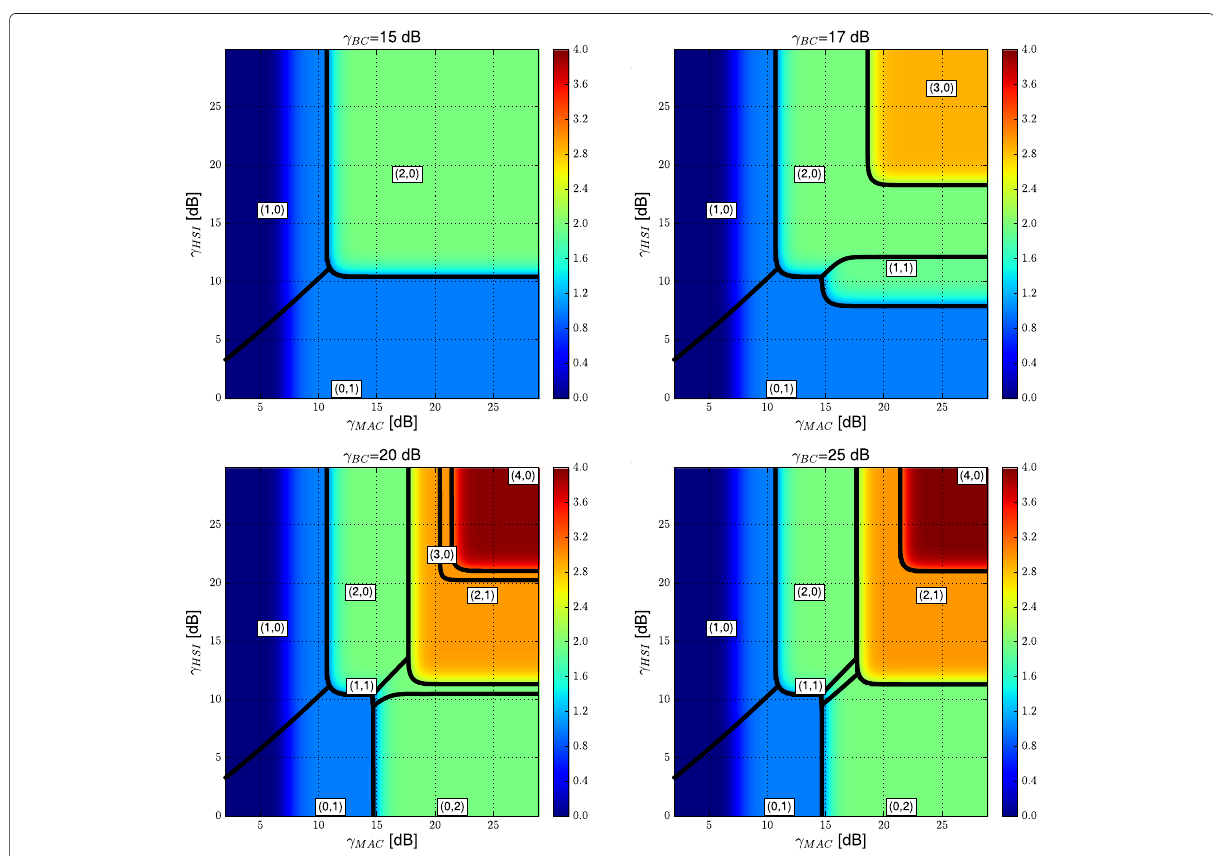
Fig. 10 Throughput performance T LB and SNR mapping regions (including the optimal const. parameters ( N I ∈ { 15dB, 17dB,20dB,25dB γ BC